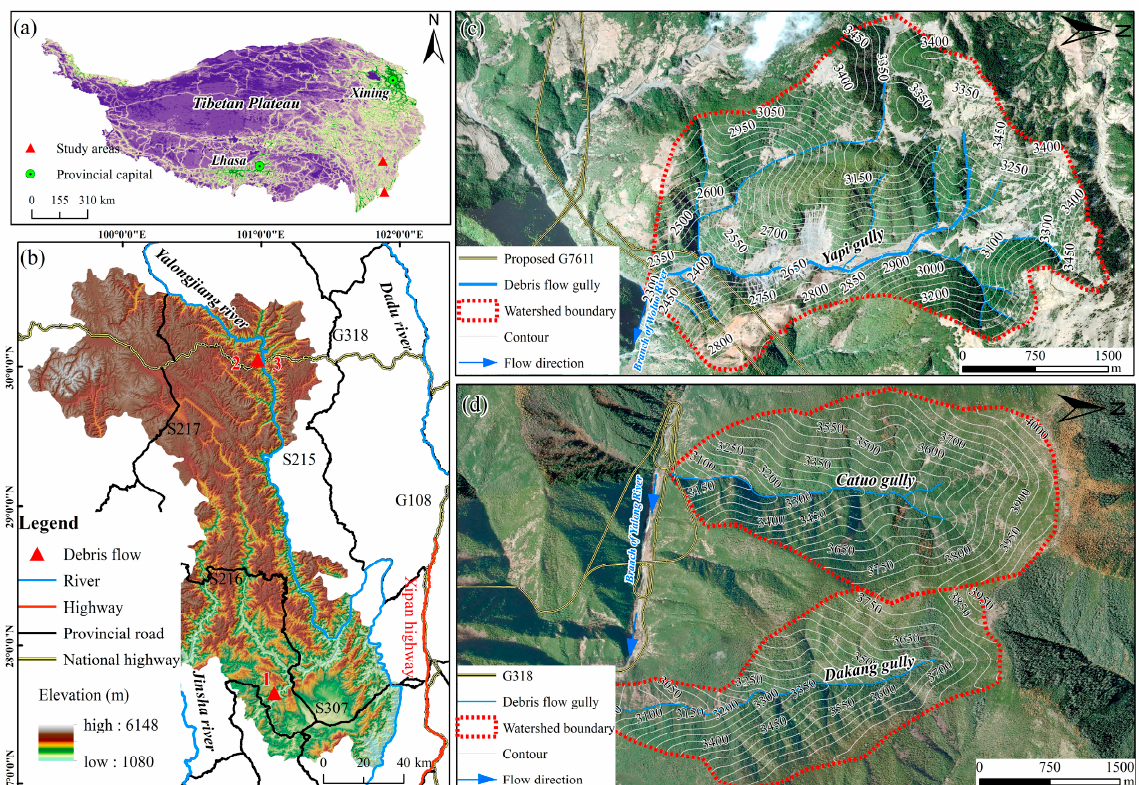
Figure 1. Regional setting of the study area. ( a ) The study area is located in the southeastern part of the Tibet Plateau. ( b ) Geomorphological features and Highways in the study area. ( c ) Geomor- phological features of Yapi gully. ( d ) Geomorphological features of Catuo gully and Dakang gully. Table 1. Geometrical features of the gullies in the Yapi gully, Catuo gully, and Dakang gully. No. Gully Name